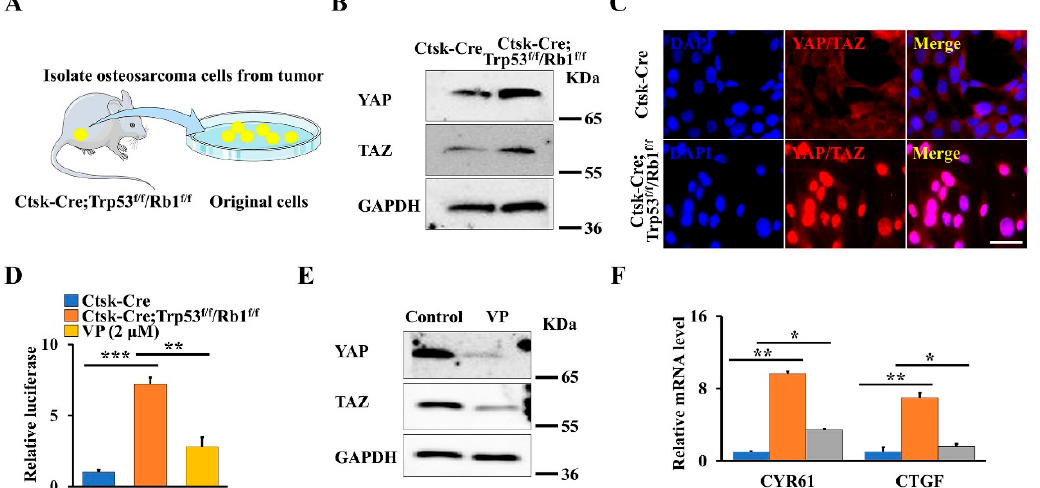
Figure 2. Loss of Trp53 and Rb1 in Ctsk-expression activates YAP/TAZ signaling. ( A ) Schematic presentation of primary osteosarcoma cells from Ctsk-Cre;Trp53 f/f /Rb1 f/f mice. ( B ) Western blot analysis of YAP and TAZ expression in primary osteosarcoma cells and normal cortical bone cells. ( C ) Representative images of immunofluorescent staining of YAP/TAZ in the primary osteosarcoma cells and normal cortical bone cells as indicated. Scale bars, 10 µm. ( D ) The normal cortical bone cells or primary osteosarcoma cells with/without 2 µmol VP were co-transfected with 8xGTIIC and pRL-TK plasmids (internal control) as indicated, respectively. After transfection of 48 h, the luciferase activities were identified by the Dual-Luciferase Assay Kit. ( E ) The primary osteosarcoma cells were treated by 2 µmol VP or DMSO (control) for 48 h, the protein levels of YAP and TAZ were identified as indicated. ( F ) qRT-PCR analysis of YAP/TAZ target genes CYR61 and CTGF in the normal cortical bone cells or primary osteosarcoma cells cultured with/without 2 µmol VP for 48 h as indicated. Error bars were the means ± SEM from three independent experiments. * p < 0.05. ** p < 0.01, *** p < 0.001.